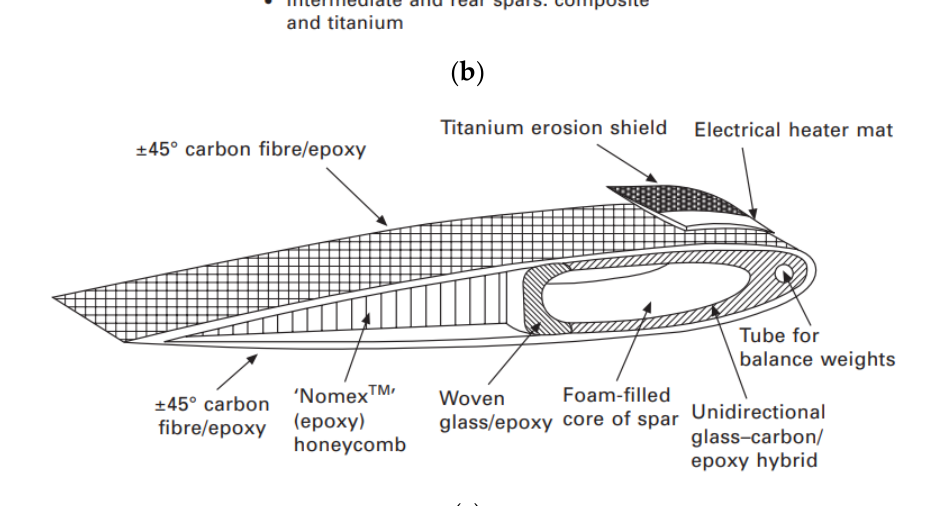
Figure 4. FRP composites in ( a ) Naval ships [19–22]; ( b ) an F-35 fighter jet [23]; ( c ) Helicopter blade [23] (reprinted with kind permission from Elsevier).